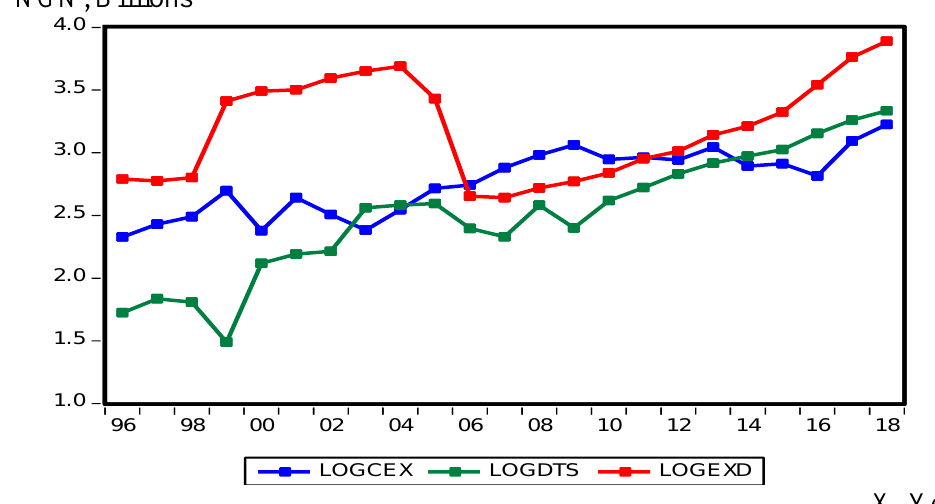
Fig. 4 . Data trends from 1996 to 2018 (Central Bank of Nigeria Statistical Bulletin, 2018).